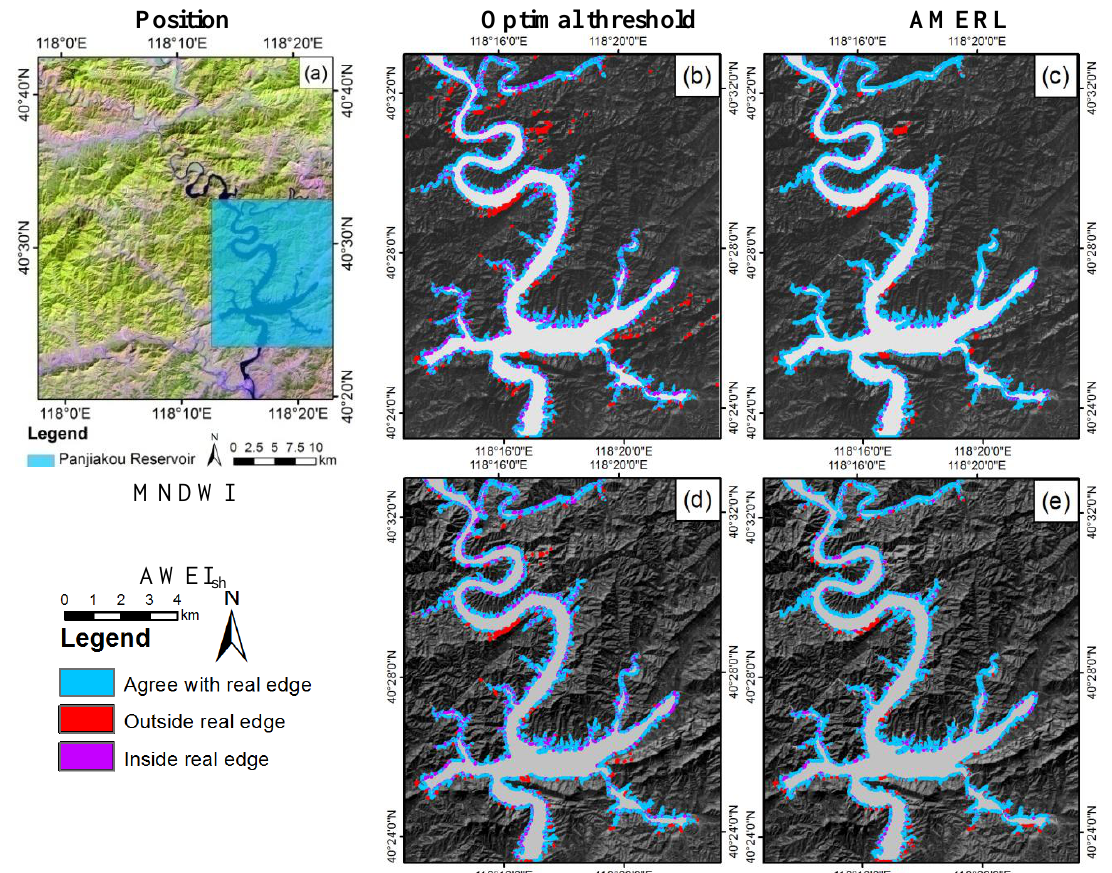
Figure 8. Comparison of reference images ( left ) the Panjiakou Reservoir extraction results using the optimal thresholding method ( middle ) and the AMERL ( right